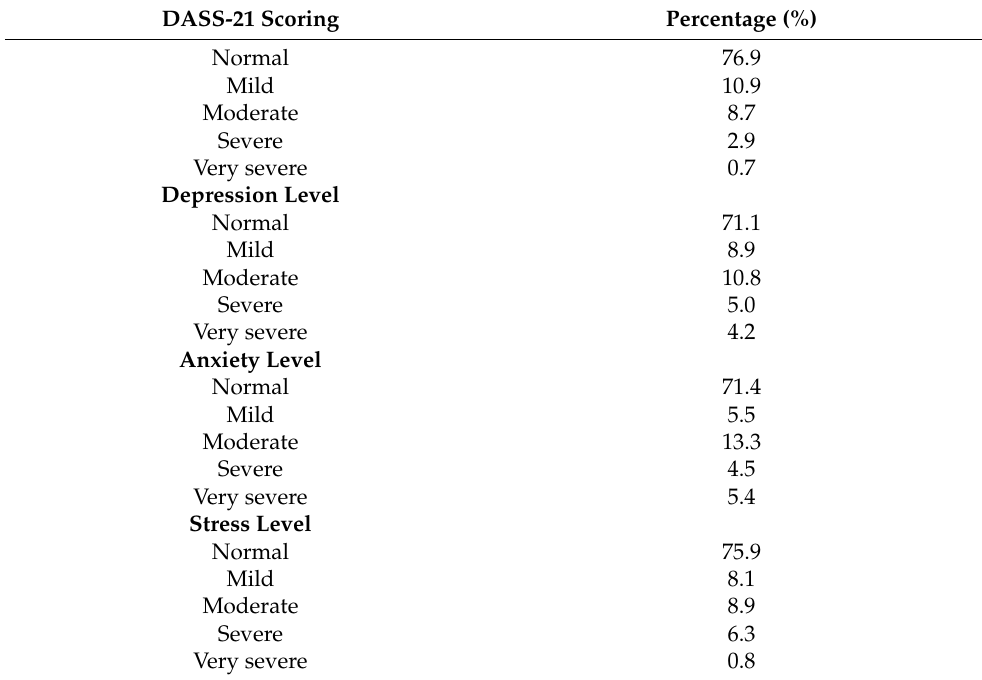
Table 2. DASS-21 score and Mental Health Problem